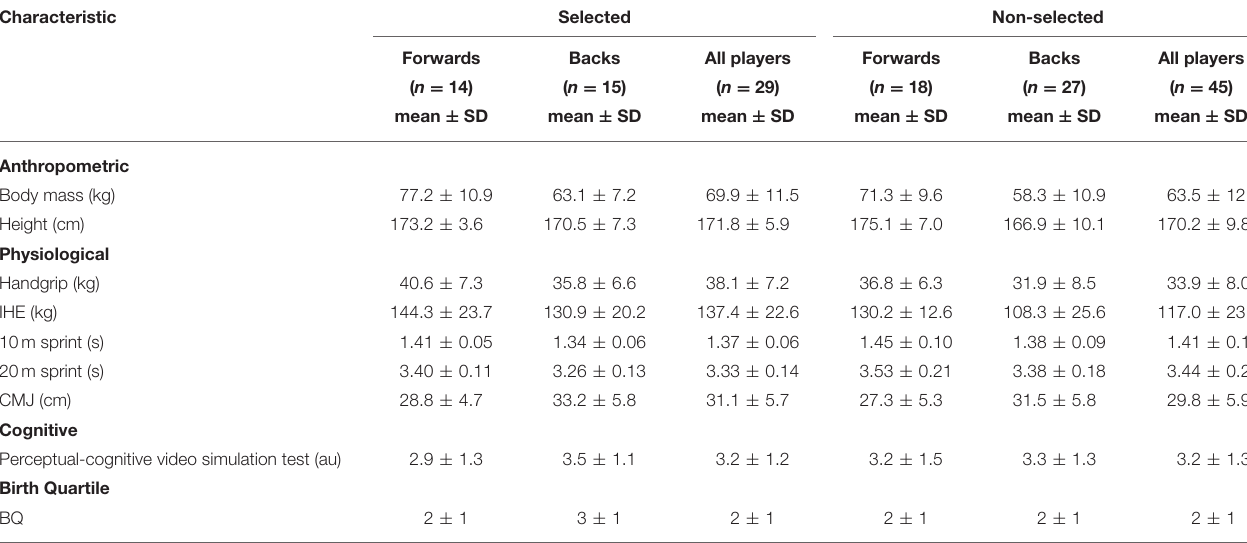
TABLE 1 | Descriptive statistics for selected and non-selected U15 players. Characteristic Selected Non-selected Forwards Backs All players Forwards Backs All players